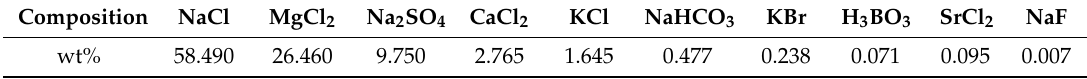
Table 2. Chemical composition of sea salt.